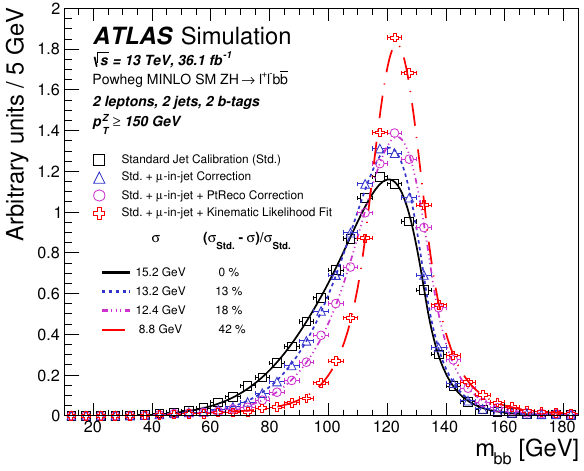
Figure 1 . Comparison of the m bb distributions as additional corrections are applied to the jet energy scale, shown for simulated events in the 2-lepton channel in the 2-jet and p Z region. A (cid:12)t to a Bukin function [92] is superimposed on each distribution, and the resolution values and improvements are reported in the